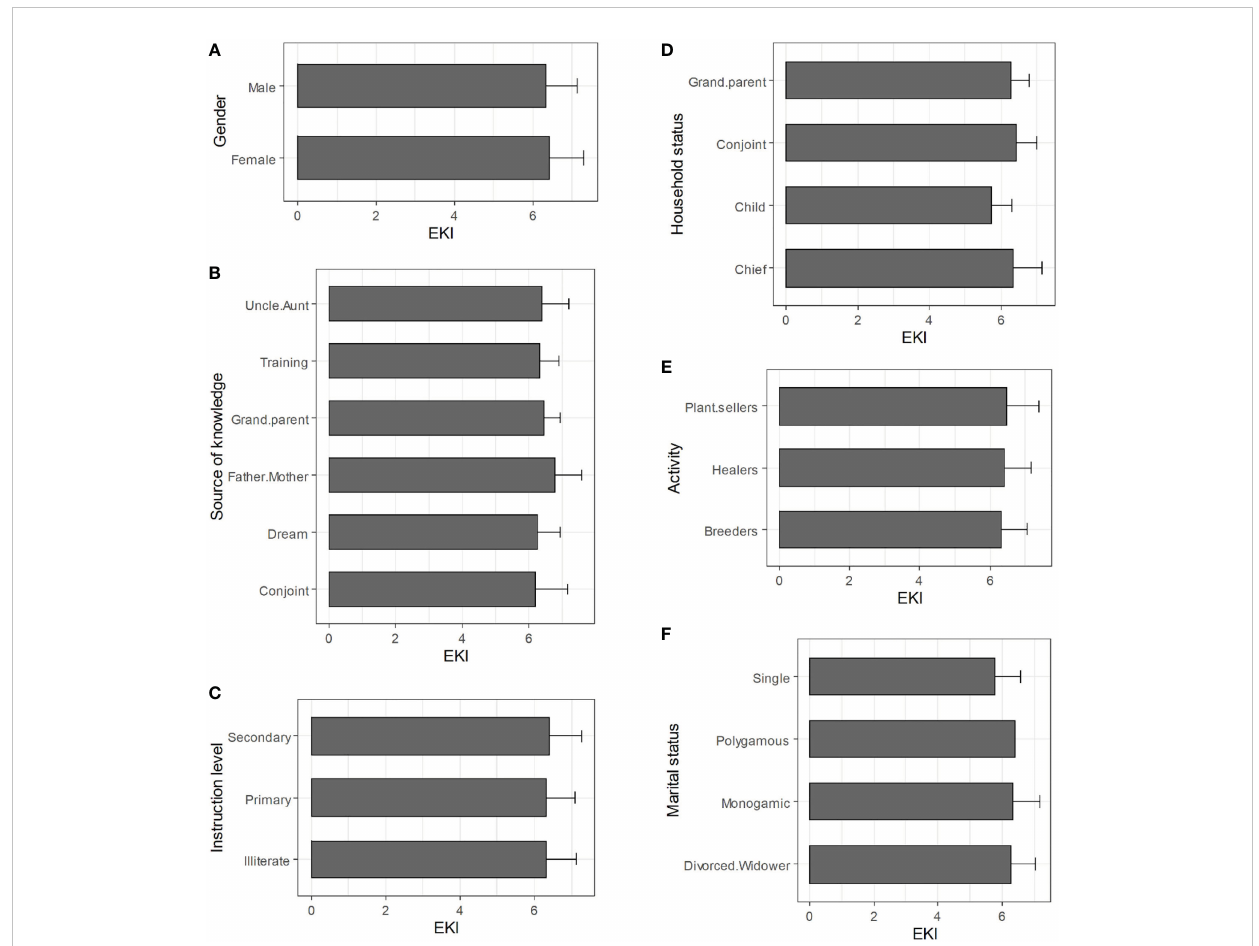
FIGURE 2 Ethnomedicinal knowledge variation by sociodemographic factors. (A) gender; (B) : knowledge source; (C) : education; (D) : household status; (E) : activity; (F) : marital status.